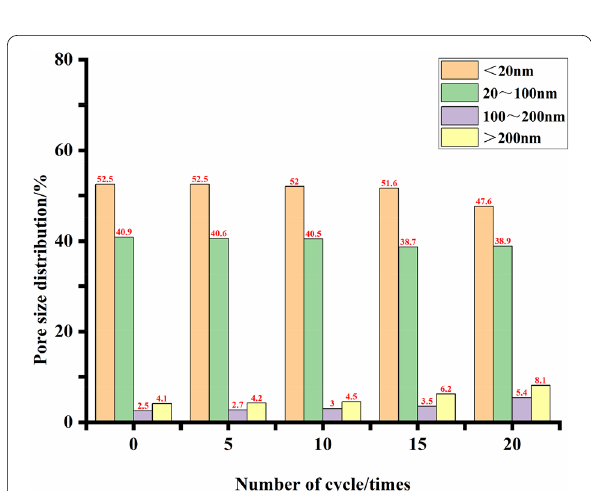
Fig. 13 The pore size distribution of concrete at different single-side salt-freezing–drying–wetting cycles (BFRC1).